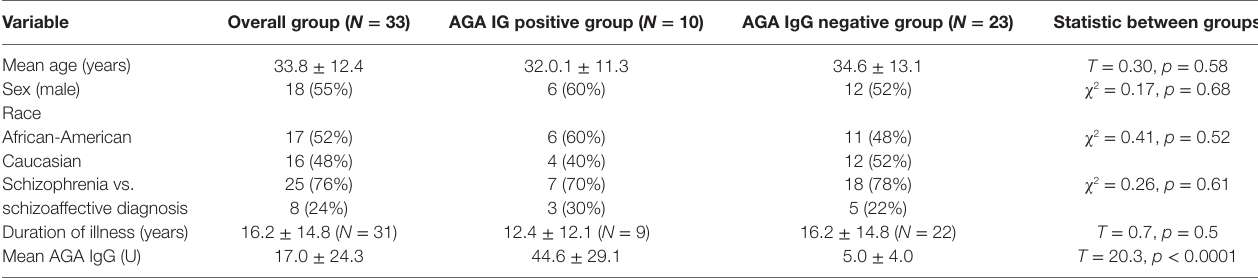
Table 1 | Demographic and clinical